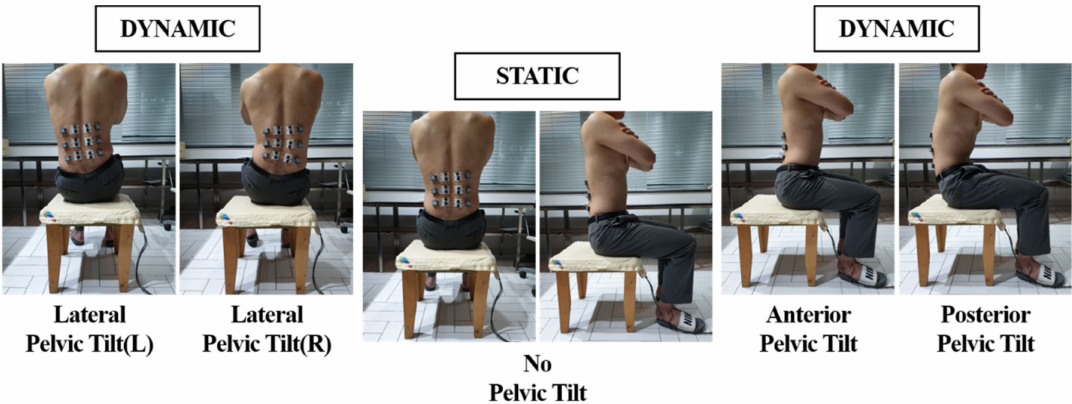
Figure 3. Static and dynamic sitting